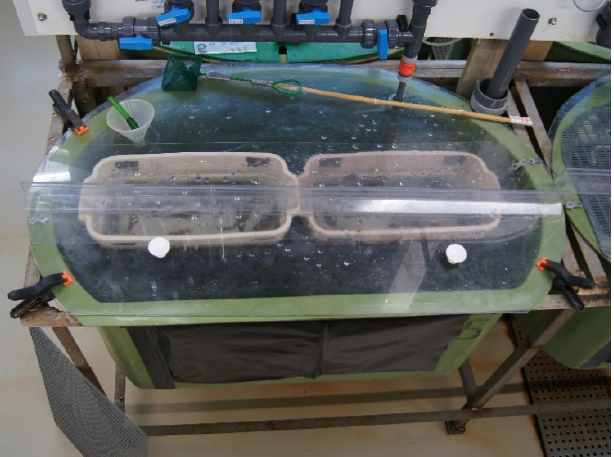
Figure 1. Photo of one challenge unit, one tank and two baskets, used in experiment 2. The 50 cohabitant fish were kept in the green 250 L tank, while the 20 VHSV ip infected fish were housed in the two greyish coloured 17 L baskets. The side walls of the baskets are made of grids allowing free water flow between the baskets and tank exposing the cohabitant fish to waterborne transmission.